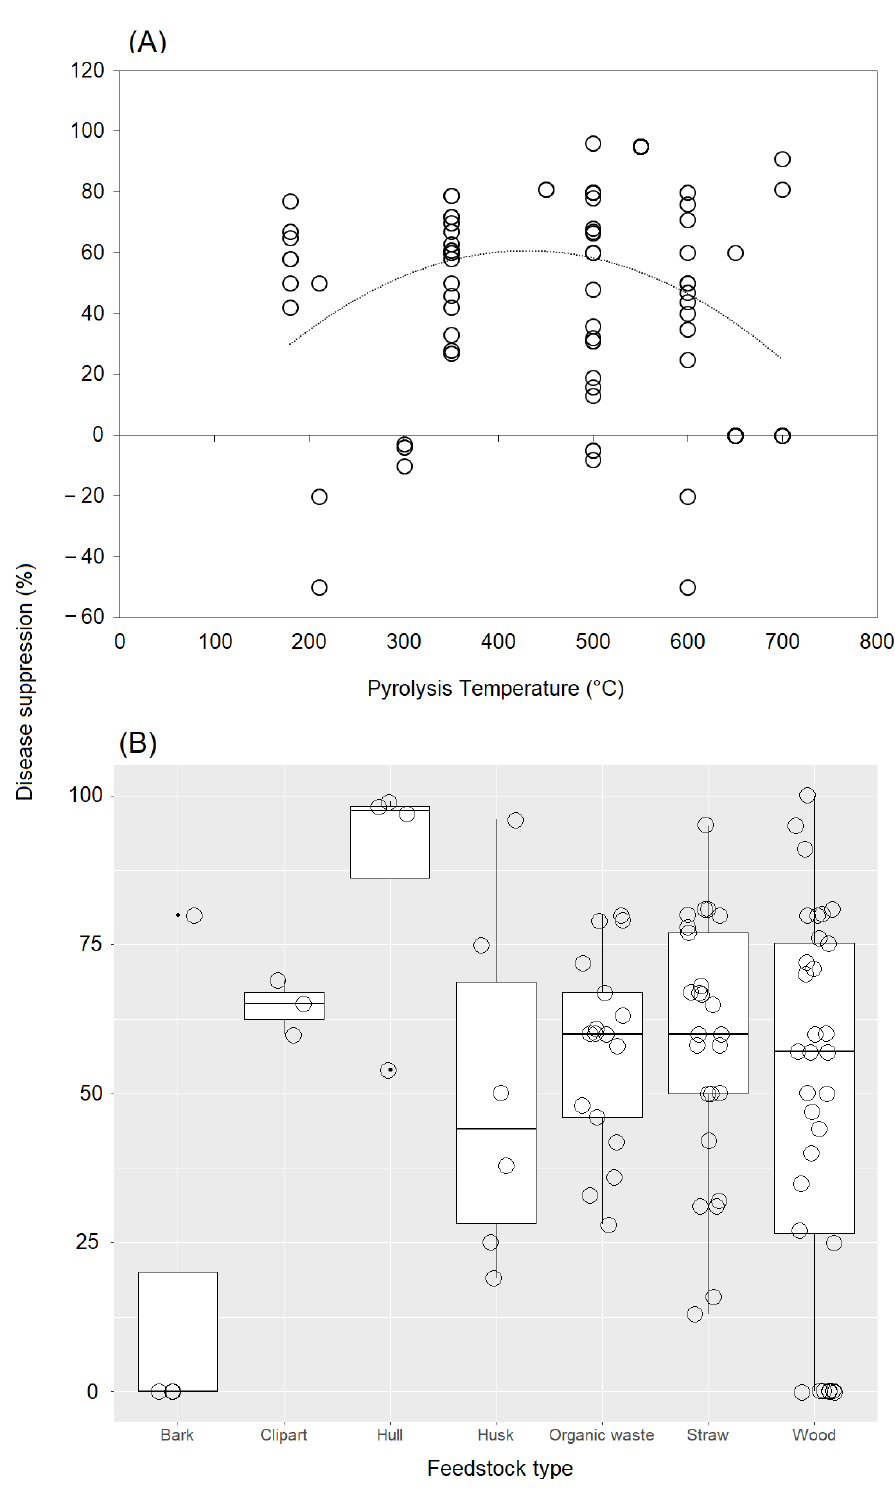
Figure 5. ( A ) Scatter diagram of the relationship between disease-suppression rate and pyrolysis temperature. The dashed black line shows a fit by logarithmic regression. ( B ) Jitter box plots of the disease-suppression rate for each feedstock type. The lower and upper bounds of the boxplots show the first and third quartiles (the 25th and 75th percentiles); the middle line shows the median; whiskers above and below the boxplot indicate the interquartile range.